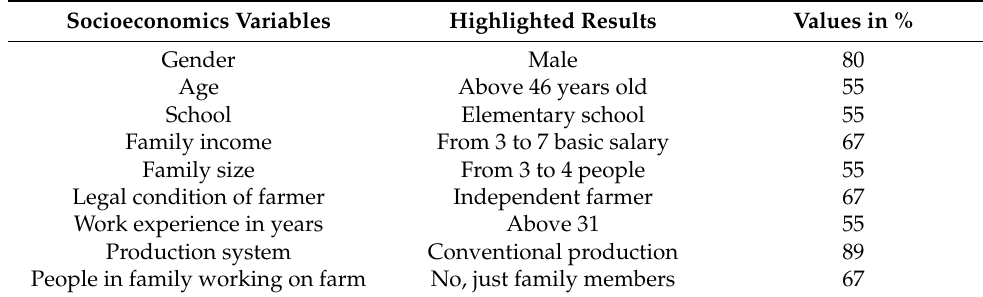
Table 1. Highlighted results on socioeconomic variables, values in %.